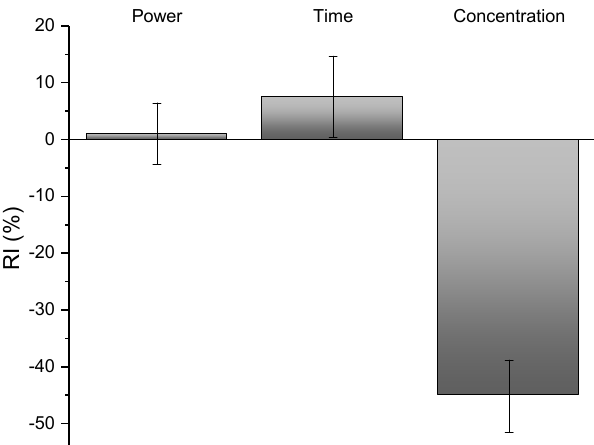
Figure 2. Relative importance of independent variables on the TPC.